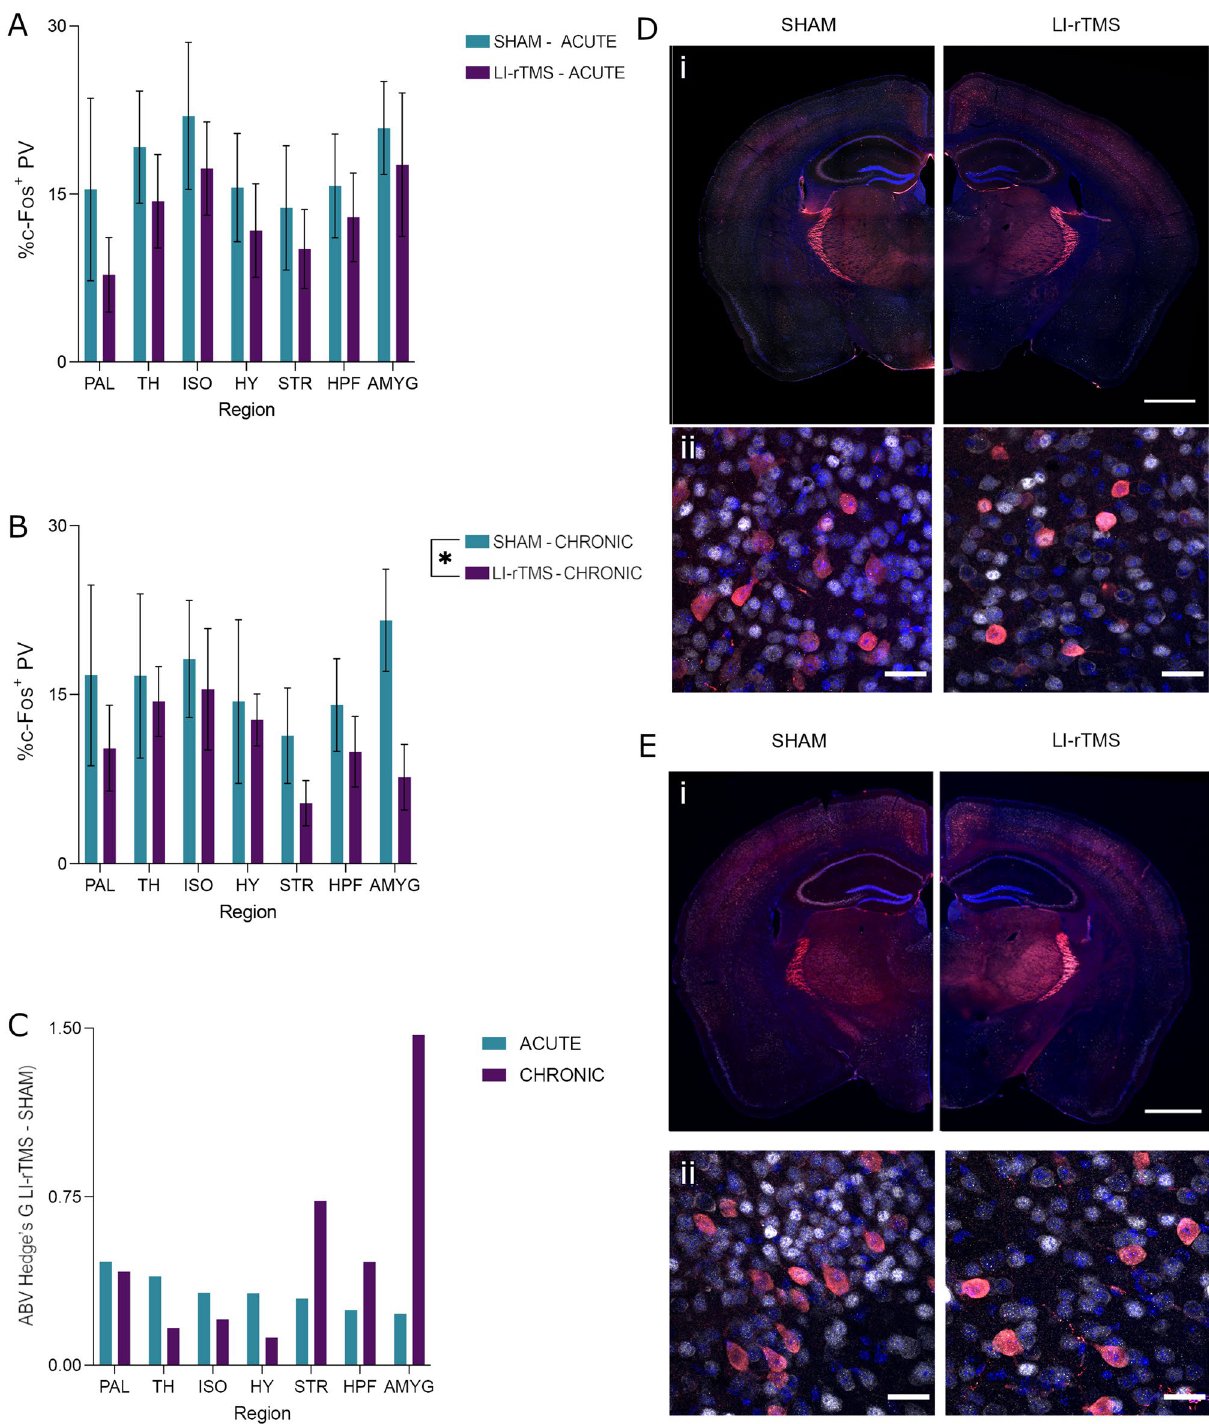
Figure 5. Percentage c-Fos/parvalbumin (PV) co-expression with acute or chronic LI-rTMS organised by brain region. ( A , B ) Percentage of parvalbumin cells co-expressing c-Fos in each region with acute ( A ) or chronic ( B ) LI-rTMS or sham controls. Error bars represent ± SEM ( C ) The absolute value (ABV) of Hedge’s G in both the acute and chronic groups. ( D , E ) Representational images of parvalbumin (red), c-Fos (greyscale) and DAPI (blue) from the acute ( D ) and chronic ( E ) groups. Scale bars represent (i) 1000 µm or (ii) 25